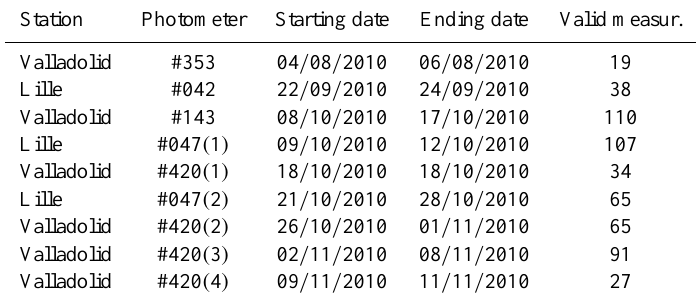
Table 1. Summary of the cross and matrix measurements done in the preliminary result tests. Station Photometer Starting date